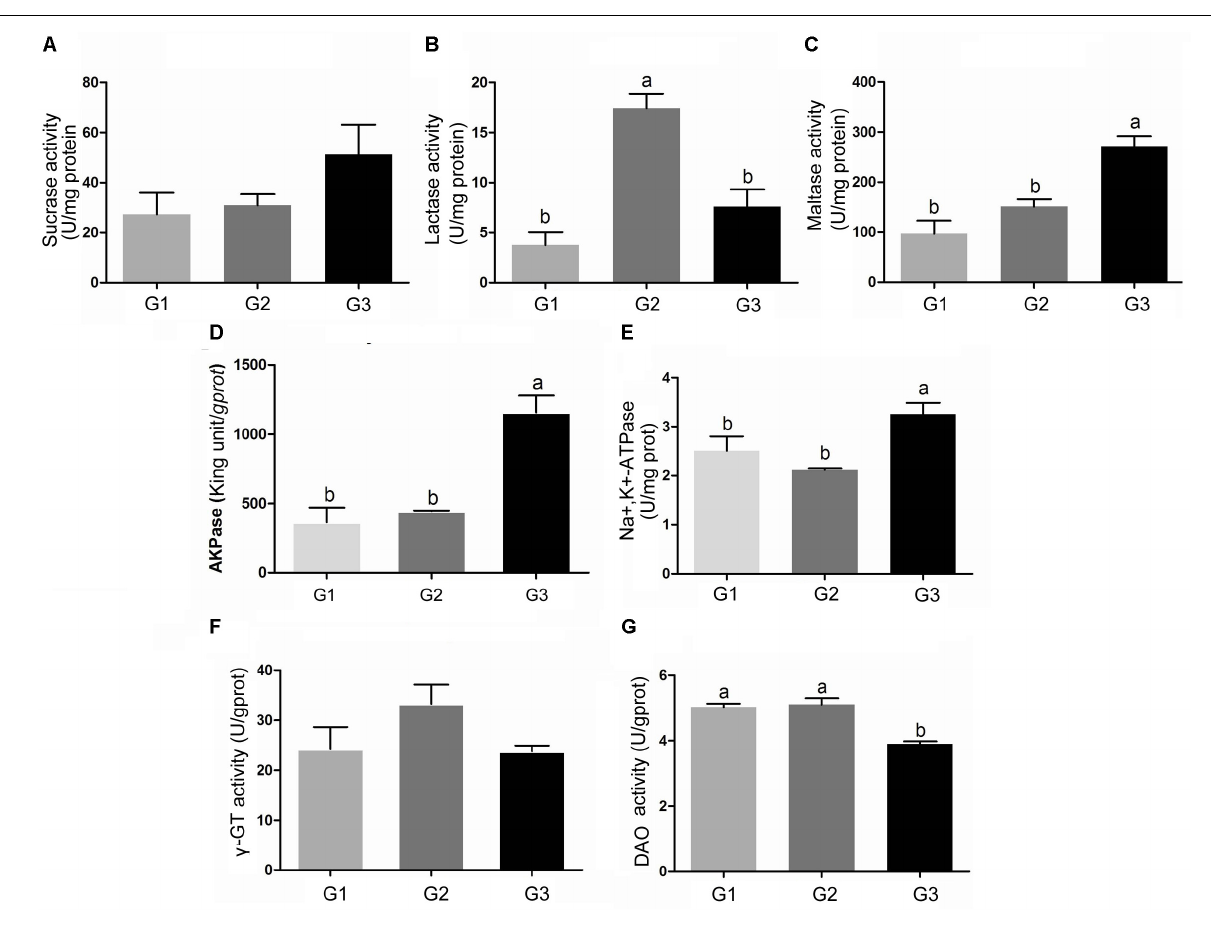
piglets (Wang et al., 2017). Hence, our study focused on the influences of probiotic Bacillus amyloliquefaciens as an alternative of antibiotics on activities of digestive enzymes in piglet